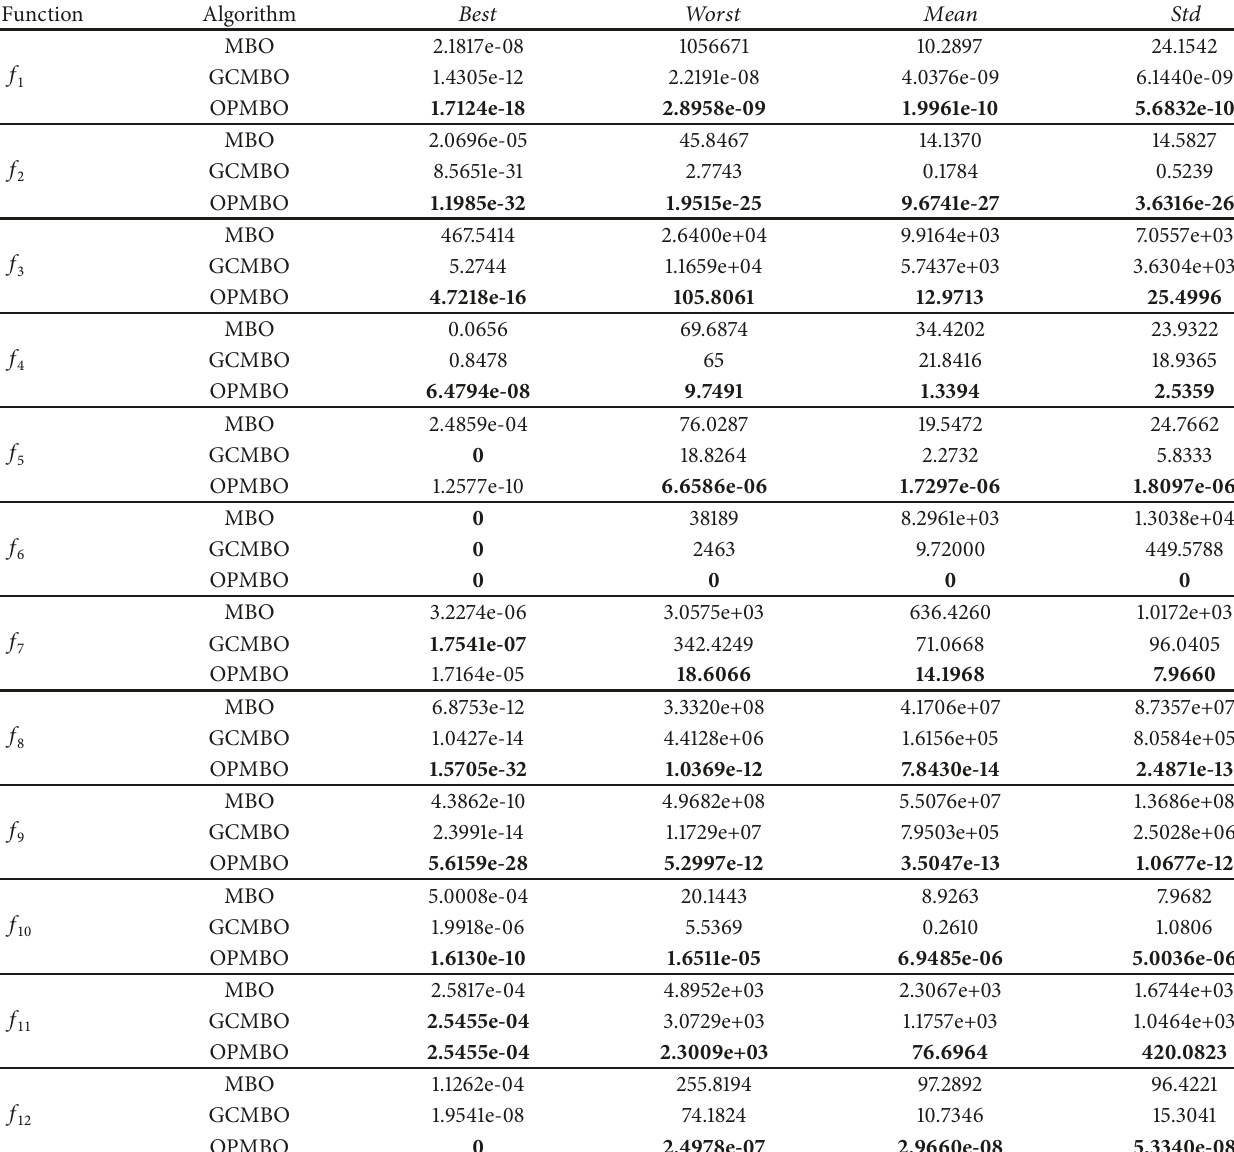
Table 3: The comparison results of the three algorithms on the 20-dimensional benchmark